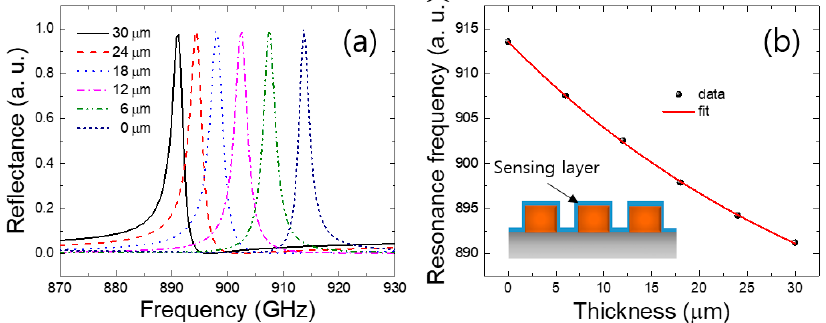
Figure 6. Dependence of the sensing-layer thickness on the ( a ) THz reflectance of the GMR device and ( b ) the resonance frequency. The inset shows the scheme of the sensing layer (blue layer) on the GMR structure.